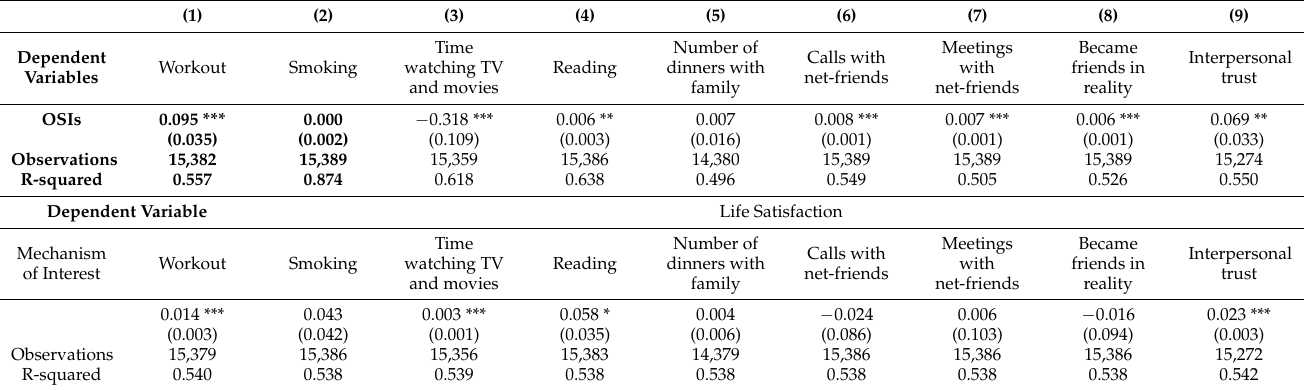
Table 3. Mechanism examination of the impacts of OSIs on the LS of older